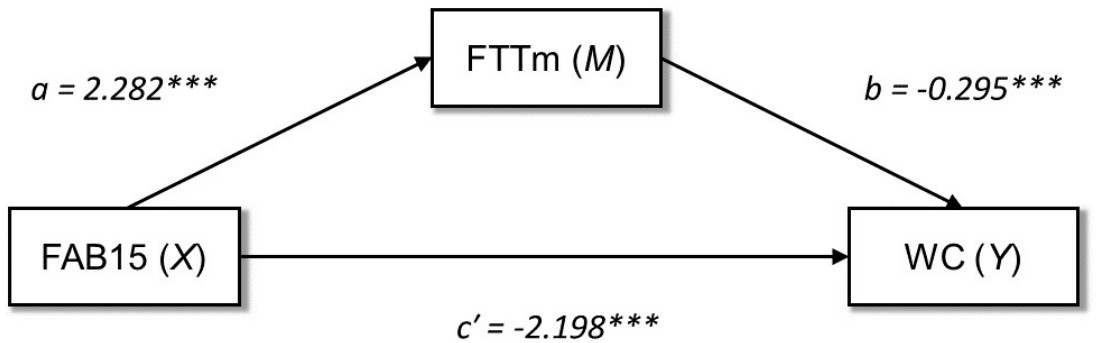
Figure 1. Graphical representation of the mediation analysis output. Note: FAB15: frontal assessment battery-15; FTTm: finger tapping task mean; WC: waist circumference; a: relationship between (X) and (M); b: relationship between (M) and (Y); c ′ : direct effect of (X) on (Y); *** p < 0.001.